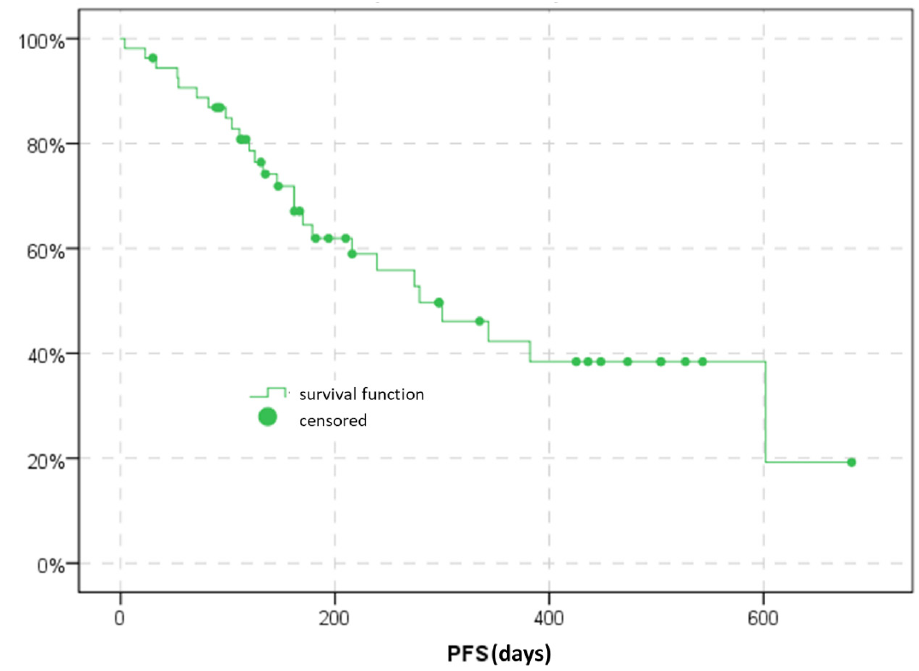
Fig. 1. Progression-free survival - all patients treated with cabozantinib.